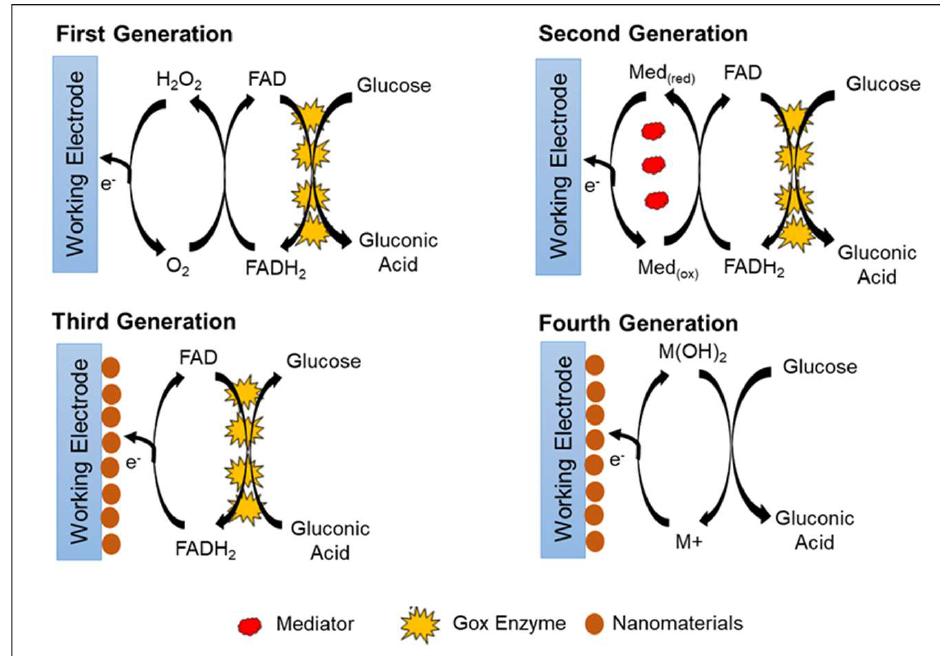
Figure 2. Schematic representation of four generations of glucose biosensors.